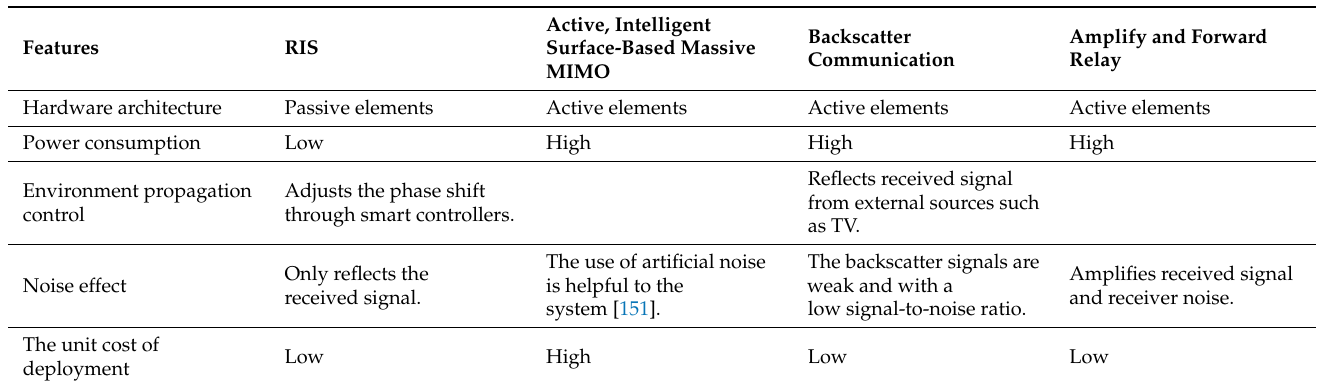
Table 10. Contrasting RIS with similar existing technologies for